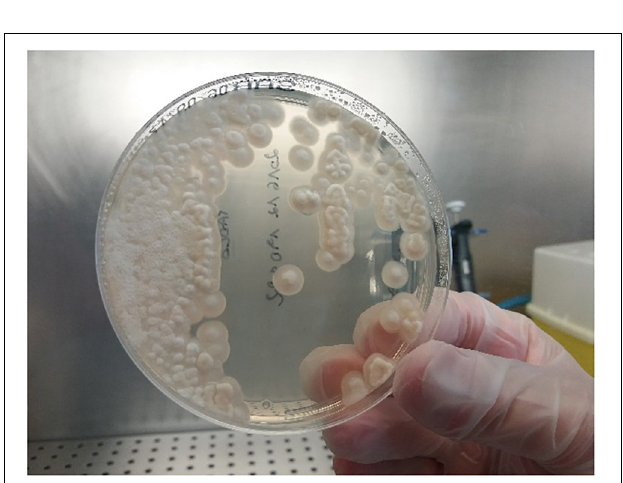
FIGURE 4 | Culture of Saprochaete clavata on Sabouraud dextrose